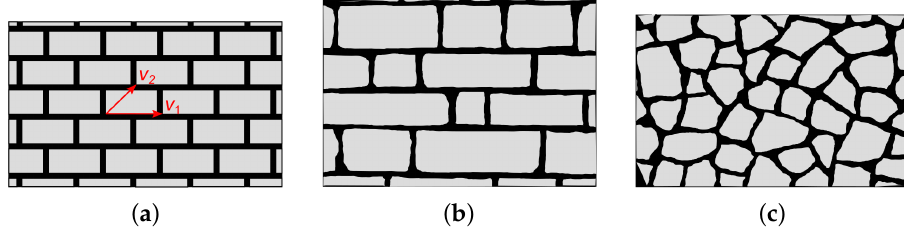
Figure 1. Masonry texture classification: ( a ) periodic, ( b ) quasi-periodic, ( c )